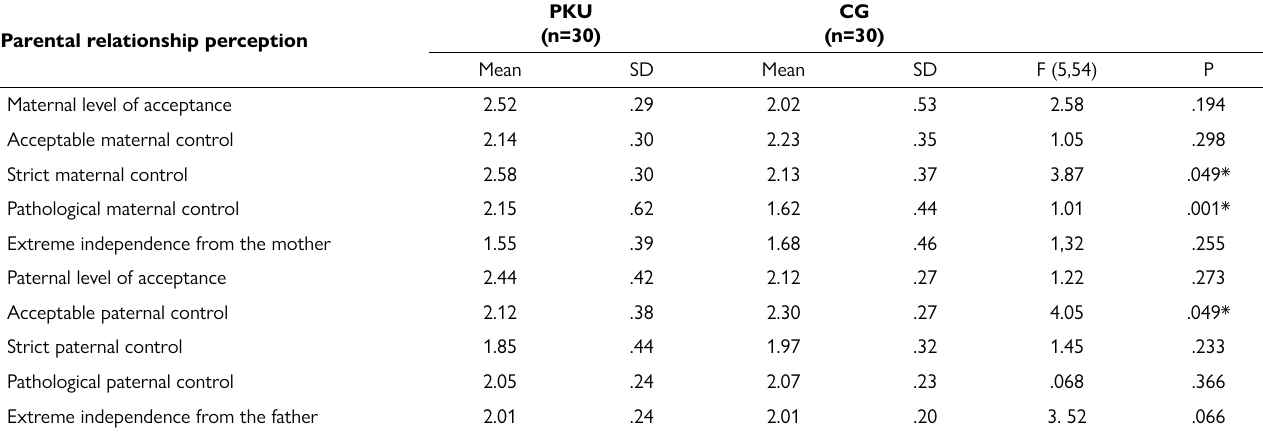
Table 2. Parental styles found in the studied PKU children vs. control group (CG).